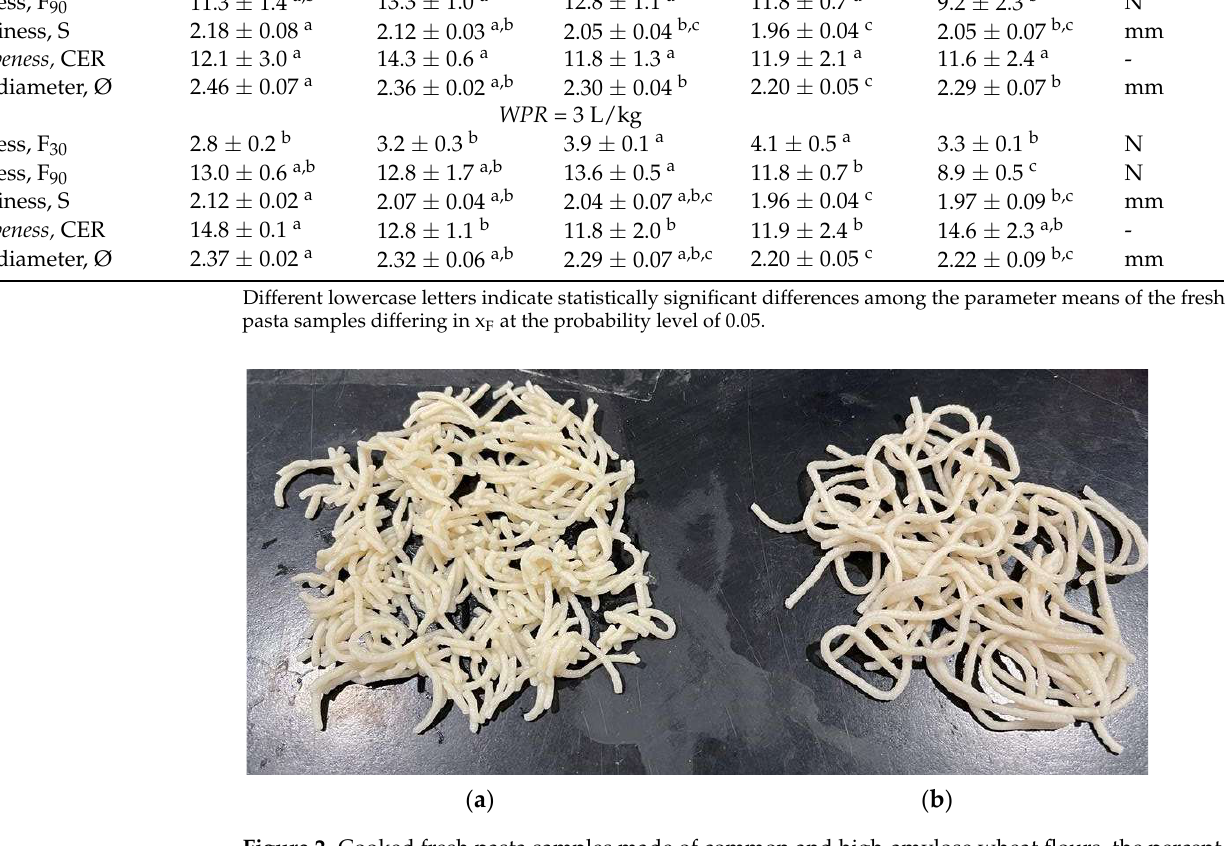
Figure 2. Cooked fresh pasta samples made of common and high-amylose wheat flours, the percentage fraction (x F ) of the latter being equal to 1 ( a ) or 0.7 ( b ) g/g. age fraction (x F ) of the latter being equal to 1 ( a ) or 0.7 ( b )